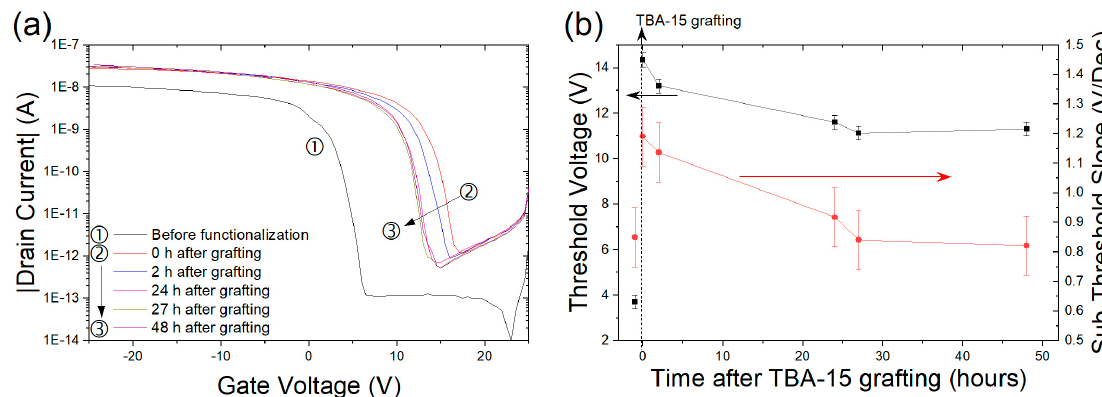
Figure 7. ( a ) Transfer characteristics of a L = 100 µm, W = 100 µm Si NN–FET before functionalization and at different times after TBA–15 grafting. The drain voltage V ds was set at − 2 V . ( b ) Sub-threshold slope (SS) (red circles) and threshold voltage (Vth) (black squares) variation for the different times analyzed. Points before time = 0 correspond to the electrical characterizations before TBA–15 probe grafting.